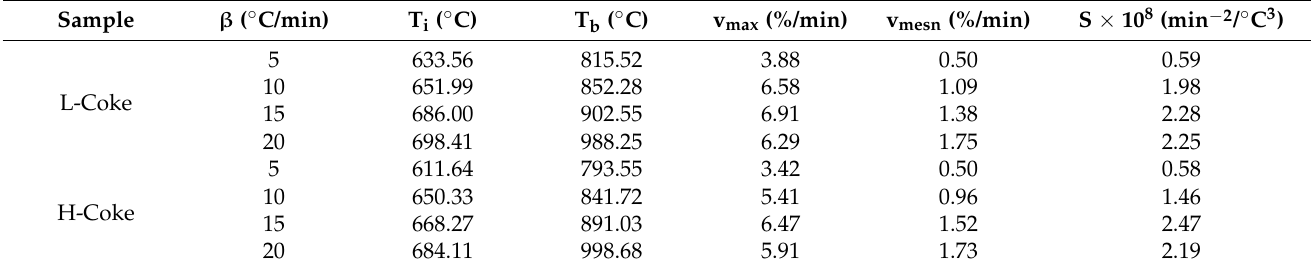
Table 2. Combustion characteristic parameters of metallurgical coke at different heating